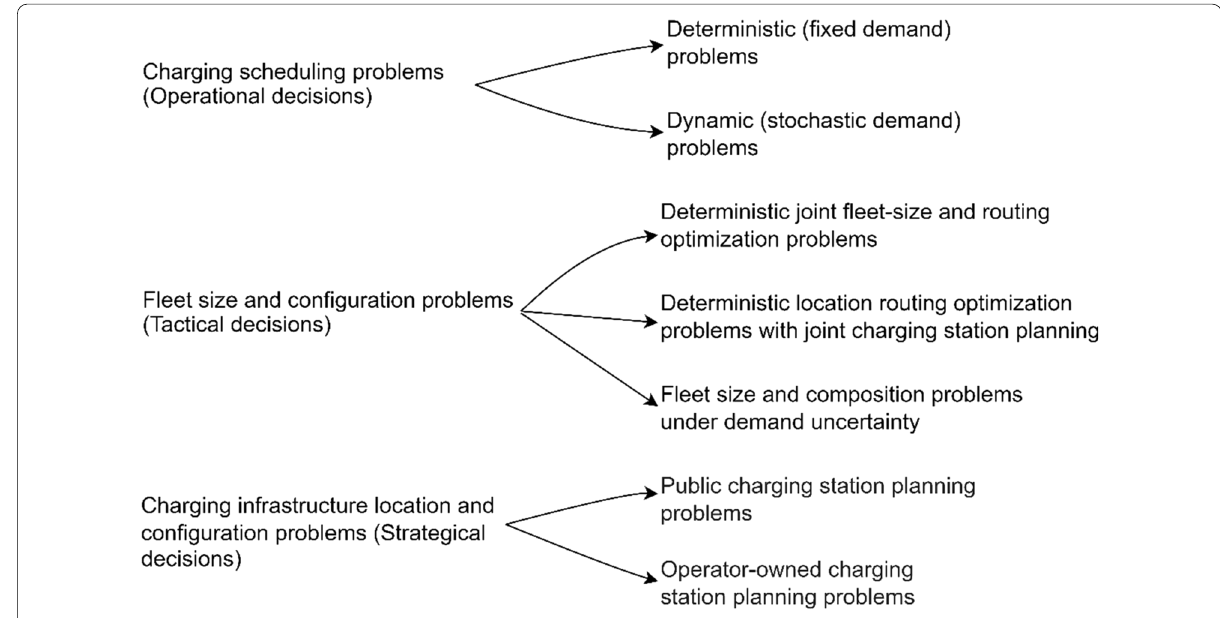
Fig. 1 EV‑DRT system planning issues reviewed in this